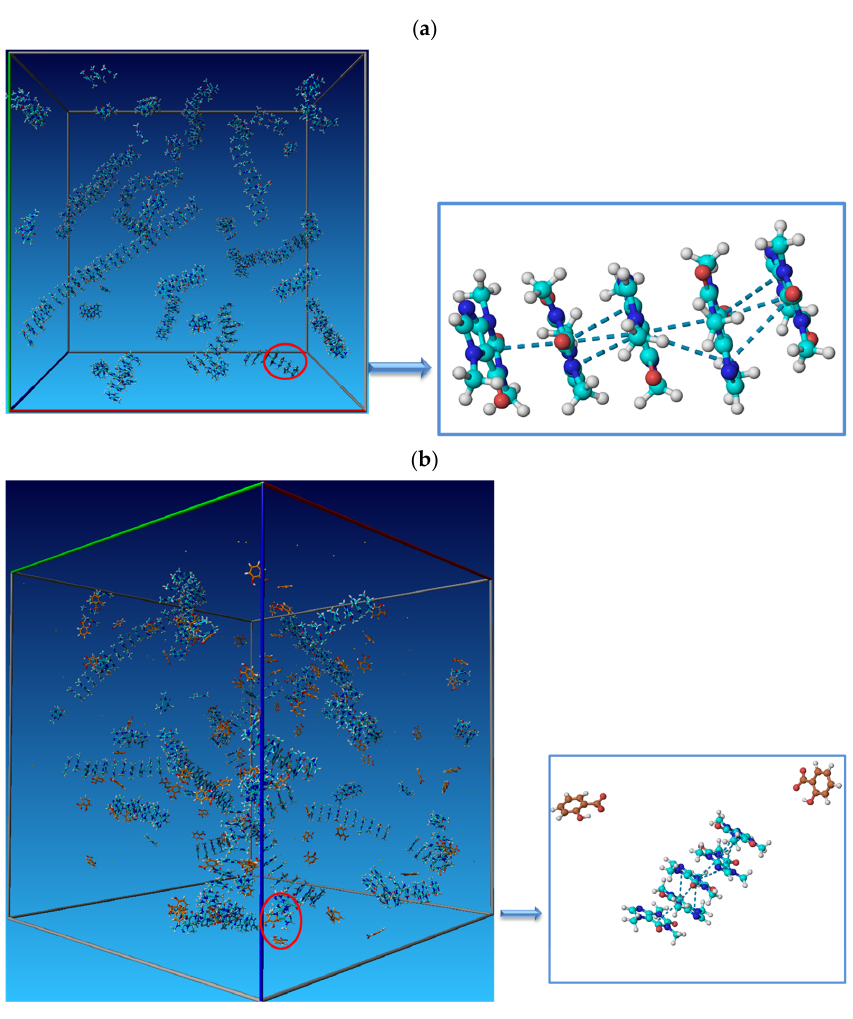
Figure 6. Visual representation obtained from the Yasara Structure program of caffeine organization in aqueous solution ( a ) and 0.1 mol ∙ kg − 1 SS aqueous solution ( b ), and blue dashed lines represent π – π interactions between caffeine molecules.